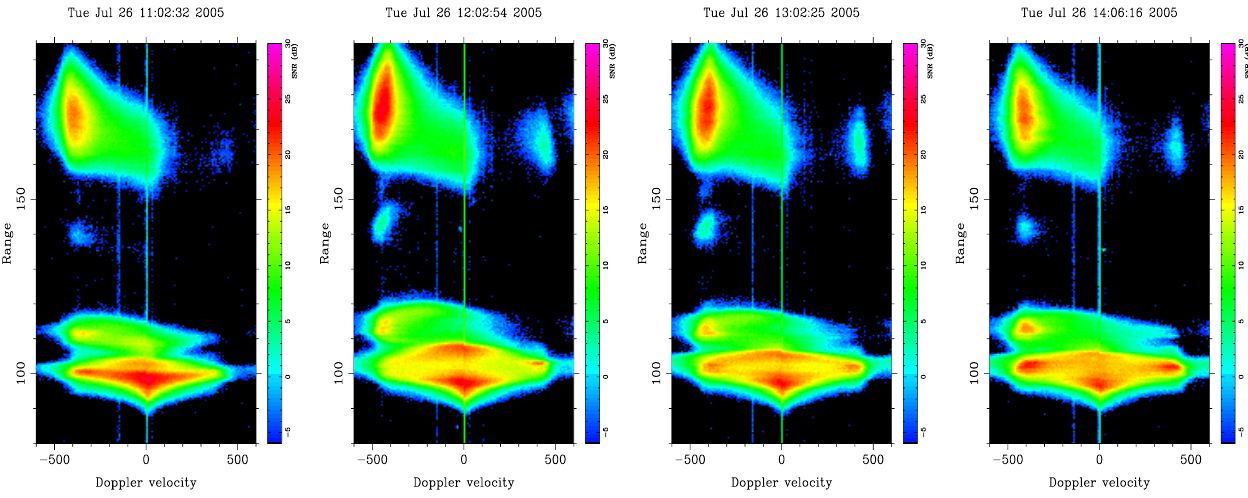
Fig. 4. Electrojet spectrograms acquired with the oblique Yagi antenna array at Jicamarca. The axes represent radar range in km and Doppler velocity in m/s. False colors indicate signal-to-noise ratio on a scale spanning − 6–30dB. Note the dramatic shifts in the slope of the echoes at distant ranges over